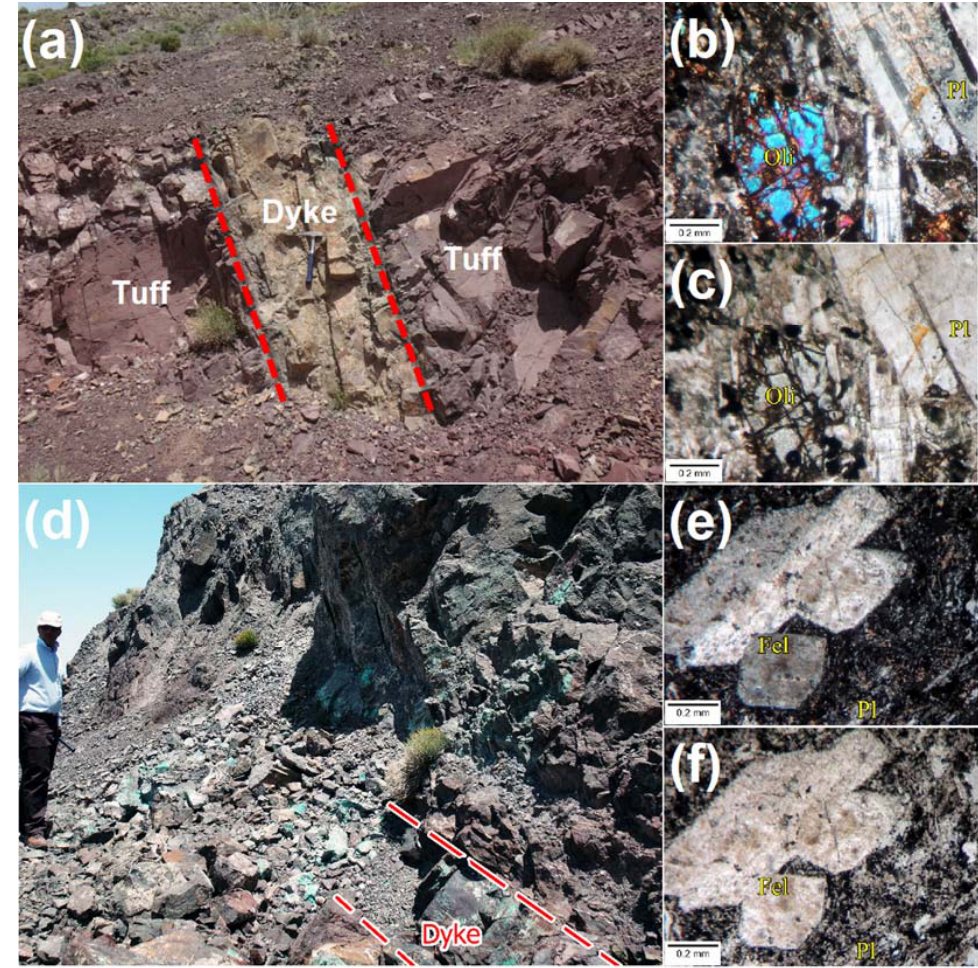
Figure 8. ( a ) Outcrop of micro dioritic gabbro dike intruded into a red tuff sequence, ( b , c ) thin section shows plagioclase and olivine minerals in XPL and PPL modes, respectively, ( d ) outcrop of a diabase dike containing Cu mineralization, ( e , f ) thin section shows plagioclase and feldspar minerals in XPL and PPL modes. Fel: feldspar, Oli: olivine, and Pl: plagioclase.